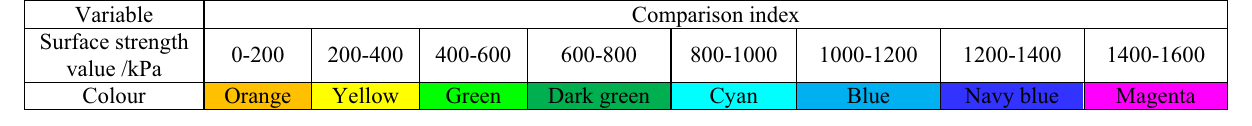
Table 4. Image partition rules.